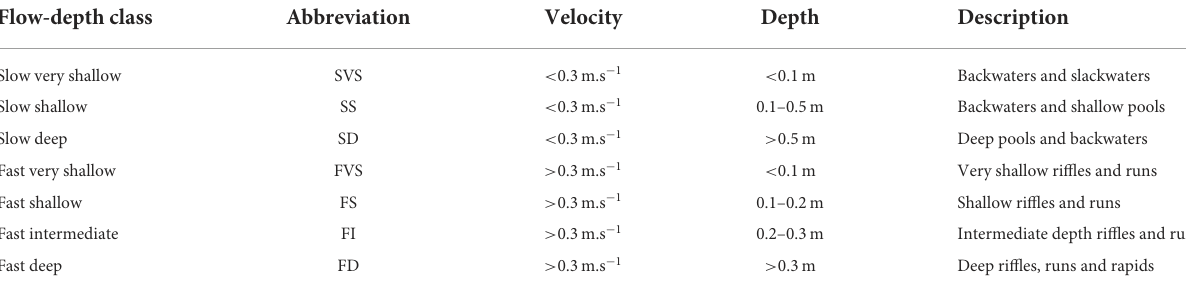
TABLE 7 Flow-depth classes for fish (Kleynhans et al.,